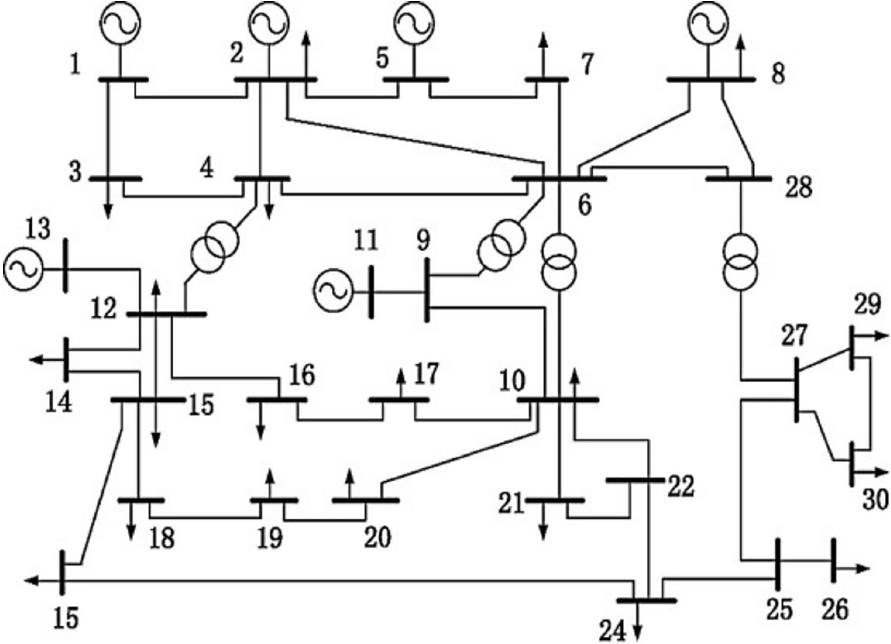
Figure 3. IEEE 30-bus system. Graphics taken from [45].